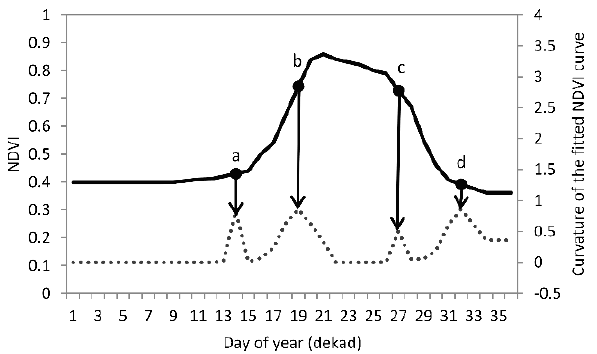
Figure 3. A schematic presentation of the annual cycle of crop phenology characterized by four key transition dates (( a ) green-up, ( b ) maturity, ( c ) senescence and ( d ) dormancy) calculated using values in the rate of change in the curvature (adapted from [46]).